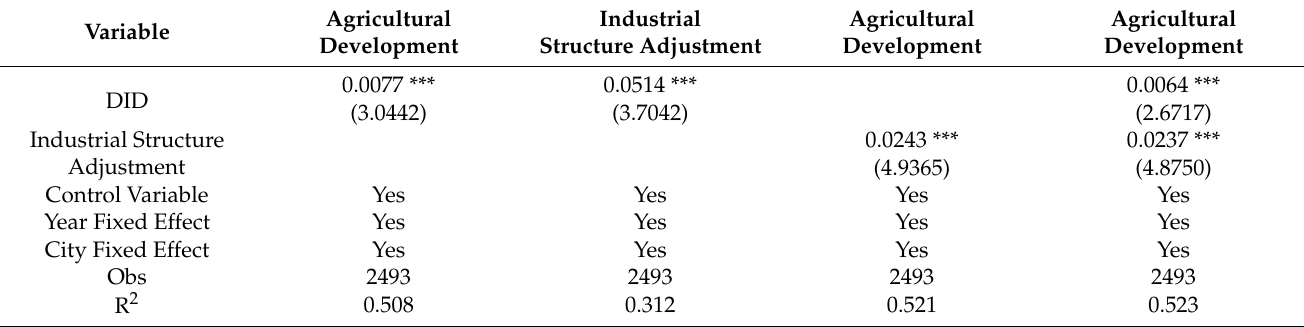
Table 5. Test results of the mediating effect of industrial structure